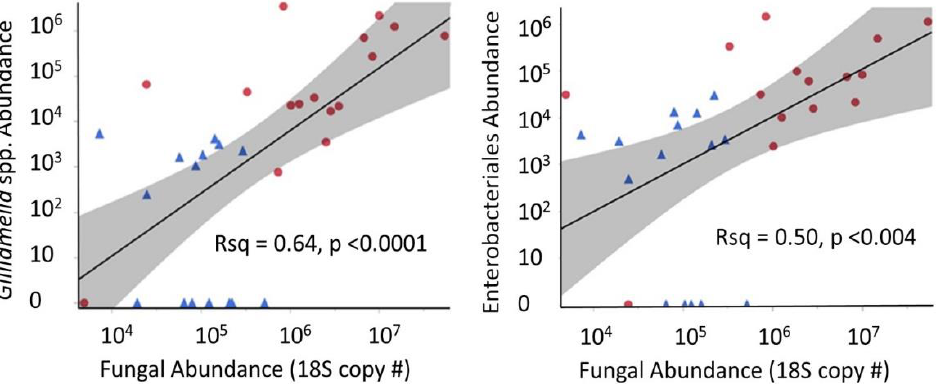
Figure 4. The significant association of bacterial and fungal abundance of two non-core bacterial OTUs overwinter in the rectum of worker bees from the warm winter (WW) environment. The Gilliamella species is unknown according to 16S sequence similarity, >3% dissimilar from both G. apis and G. apicola . The Enterobacteriales OTU is also uncharacterized. Blue triangles represent early WW rectum samples and red circles represent late WW rectum samples. Both axes are logarithmic scale (Log10).